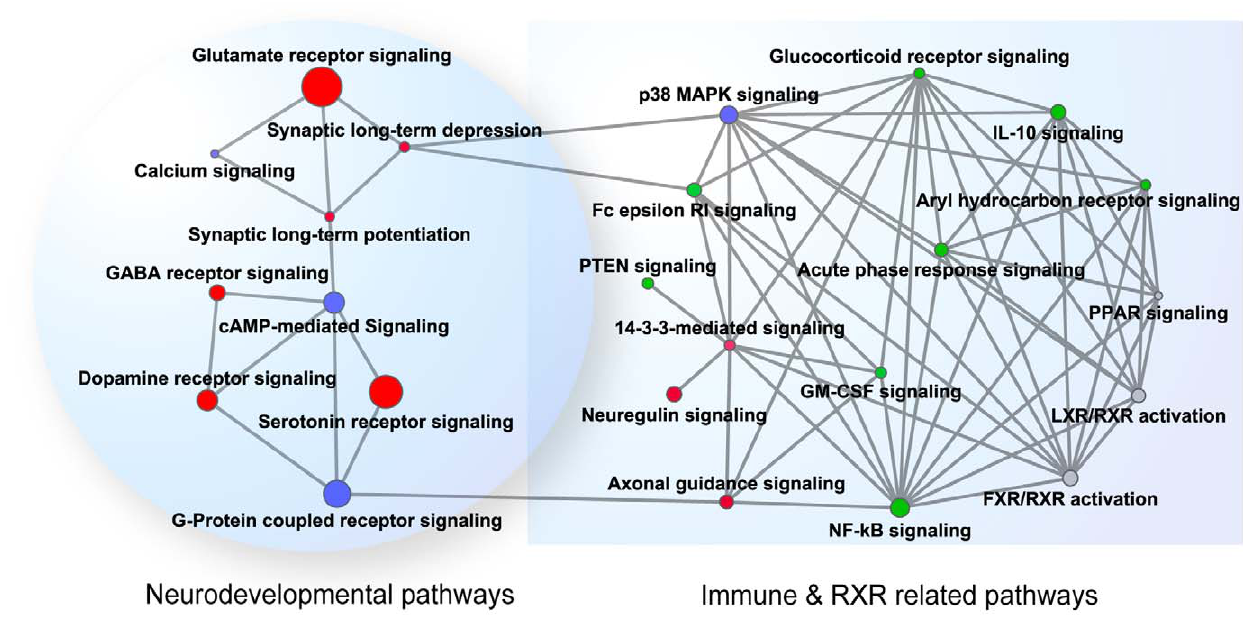
Figure 3. Crosstalk among SZ-enriched pathways. Nodes represent pathways and edges represent crosstalk between pathways. Node area corresponds to its score, which is 2 10 logarithm of Fisher’s exact test P value. Red nodes: neurodevelopmental pathways; blue nodes: common signaling pathways; green nodes: immune-related pathways; and grey nodes: RXR (retinoic X receptor) related pathways.